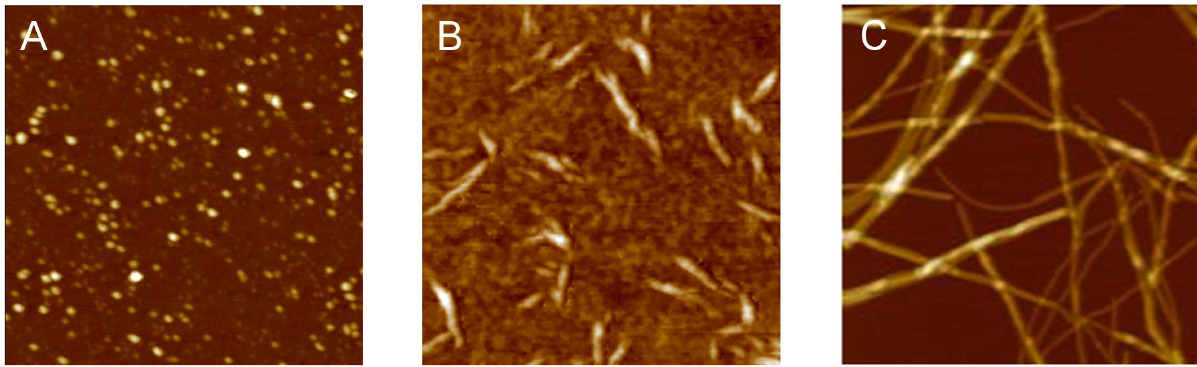
Figure 3. Atomic force microscopy images of representative steps of amyloid aggregation: ( A ) oligomers; ( B ) protofibrils; ( C ) mature fibrils. Scan size 1.0 µm. Z range (A) 8.0 nm; (B) 15 nm; (C) 20 nm. Relini, unpublished